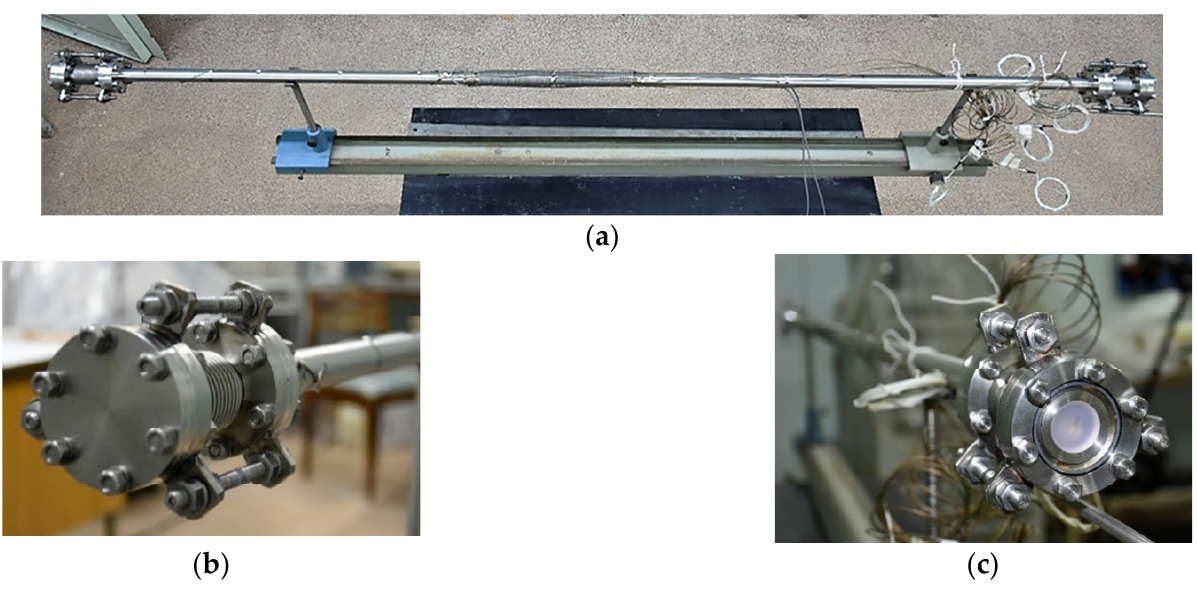
Figure 5. Irradiation device for experiments at IGR reactor: ( a ) ID assembled; ( b ) the lower aligner of ID with flange plug; ( c ) the upper aligner with vacuum window.